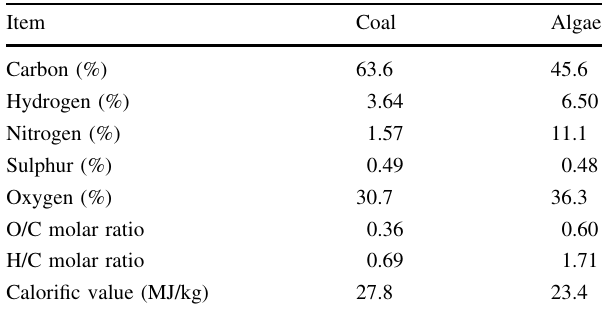
Table 2 Ultimate and energy properties of coal and algae (dry ash free basis)